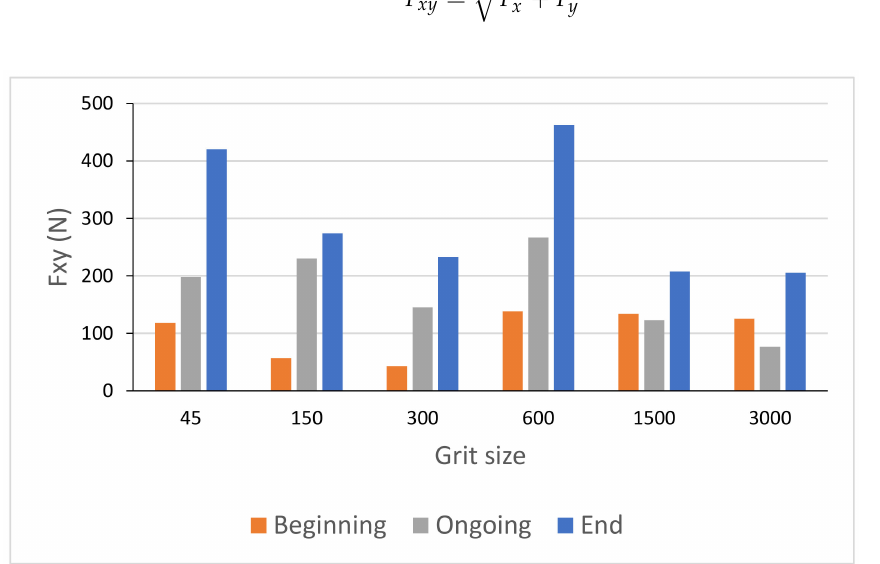
Figure 21. Cutting forces F xy as function of grit size for white granite polished with Vs = 2500 rpm and f = 1000